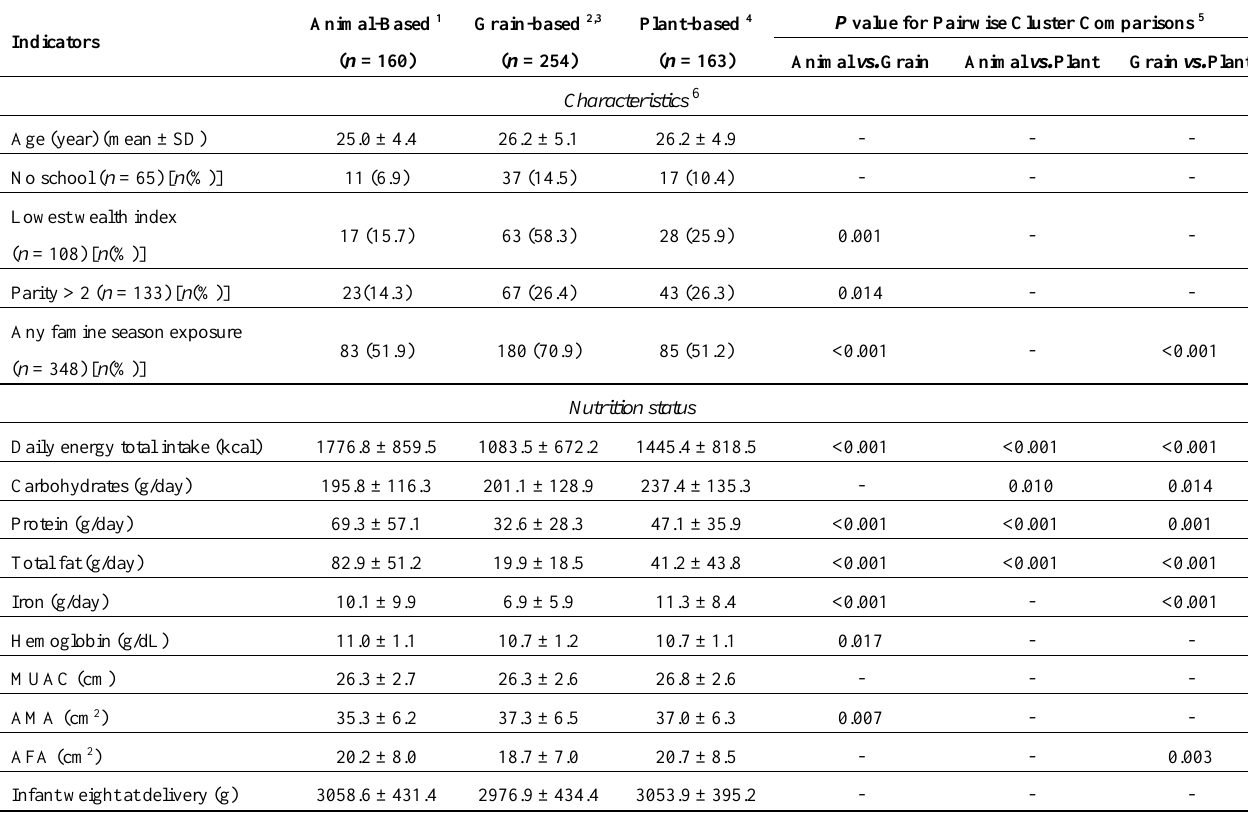
Figure 1. Cluster analysis of dietary patterns among HIV-infected Malawian pregnant women. Table 2. Demographic, nutrient, and clinical indicators by the 3 diet clusters among 577 pregnant women participating in the BAN